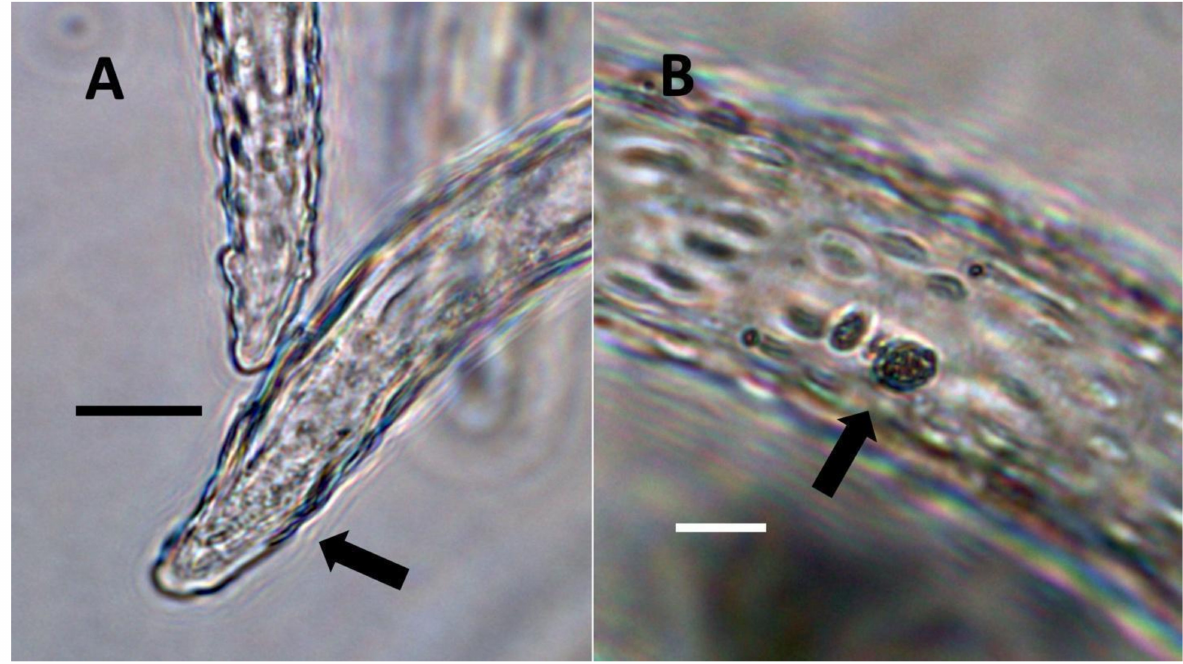
Figure 4. Pitted trichome of Ailanthus altissima showing bacteria. ( A ) Developing trichome stained with acidified diphenylamine showing nitrate (blue color) around bacteria (arrow) in the tip of the trichome (Bar = 10 µ m). ( B ) Trichome stained with sulfur monochloride to show bacteria (arrow) emerging from lateral pits in wall (Bar = 10 µ